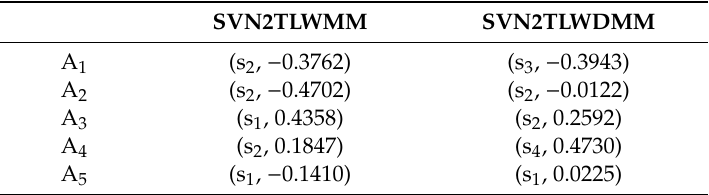
Table 3. The score values of the green